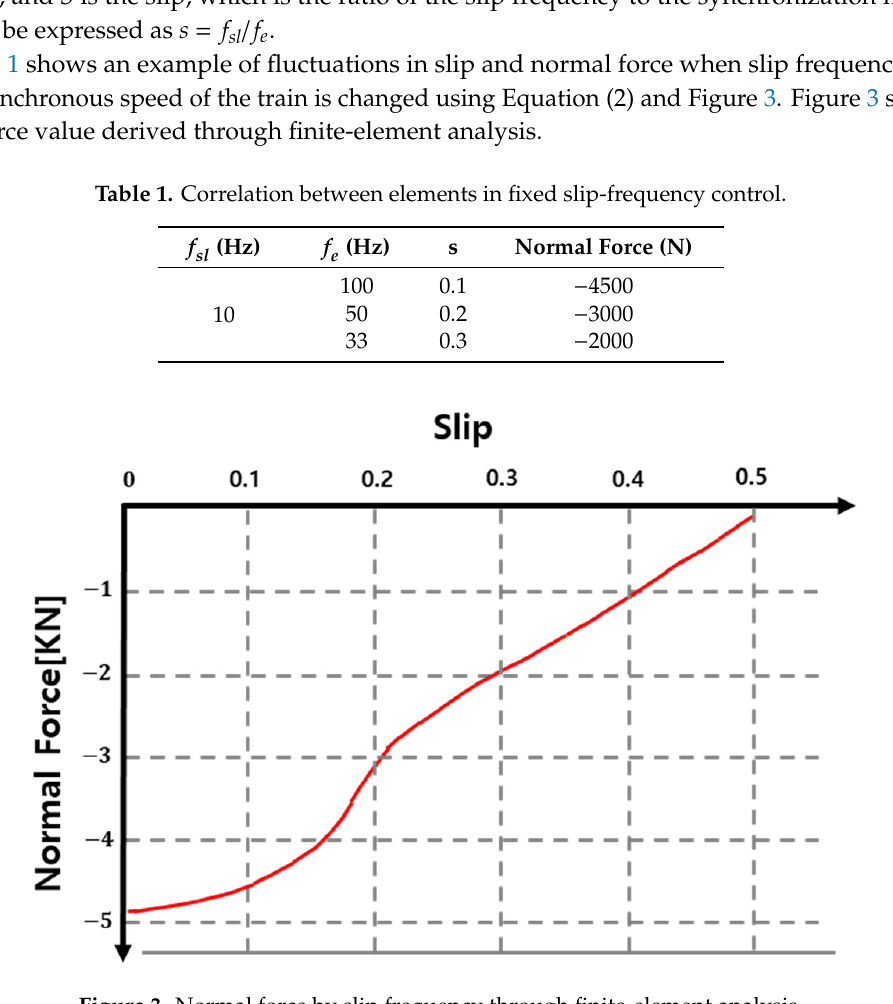
Figure 3. Normal force by slip frequency through finite-element analysis. Table 1. Correlation between elements in fixed slip-frequency control.